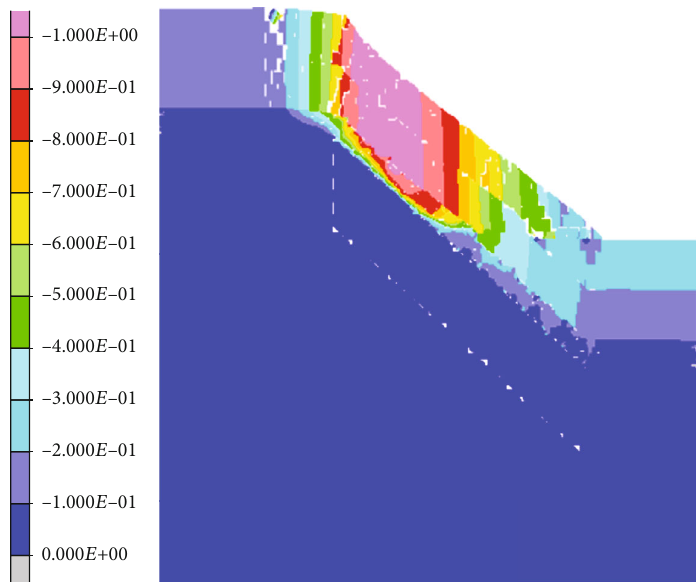
Figure 8: Displacement cloud diagram in the yy direction when running 160,000